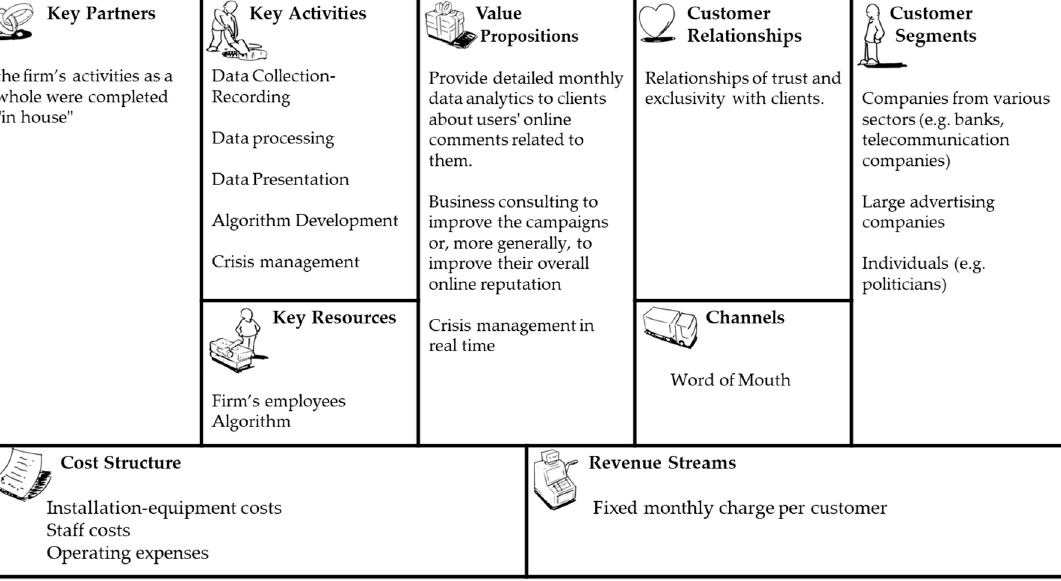
Figure 3. Trek’s Business Model Canvas in its Infancy Stage. Adapted from (Osterwalder and Pigneur 2010).